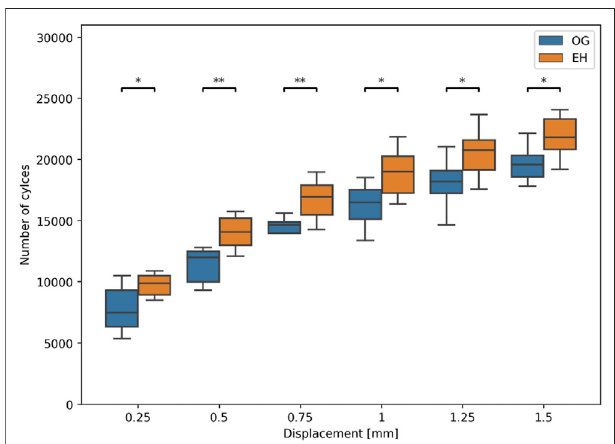
FIGURE 6 | Experimental number of cycles to cut-out failure at different levels of residual relative head fragment displacement with respect to the plate. Asterisks indicate signi fi cant differences between OG (blue) and EH (orange) implant designs. (*: p ≤ 0.05; **: p ≤